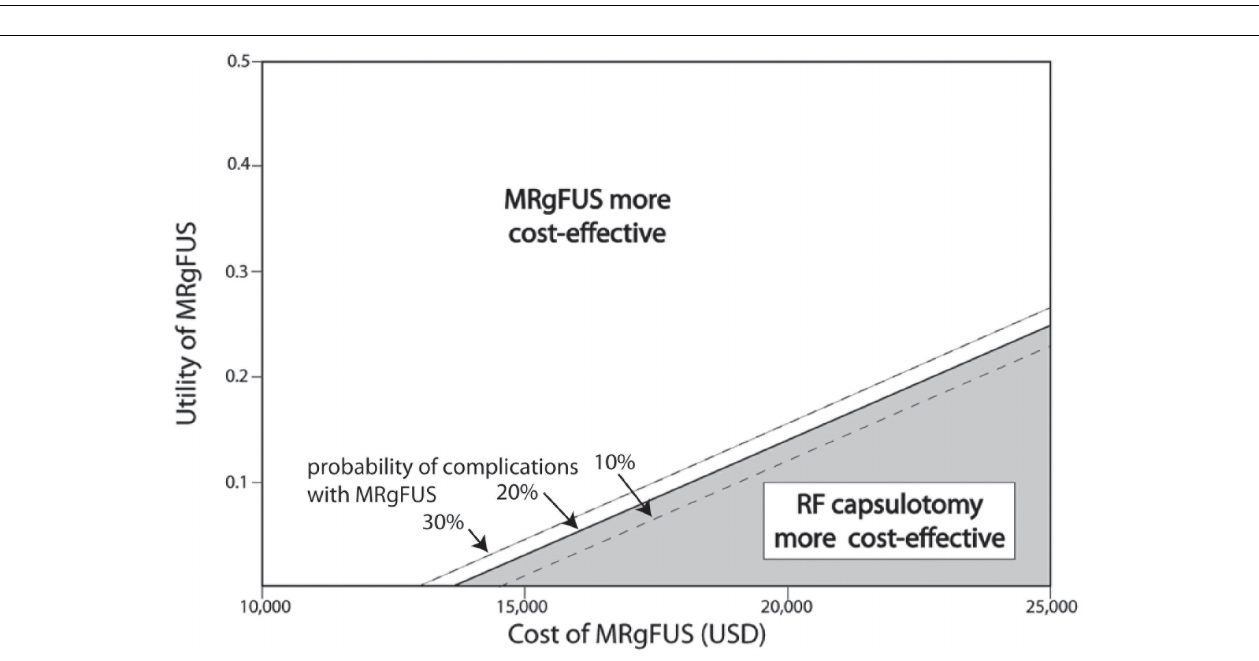
FIGURE 1 | Decision tree comparing MgFUS and RF capsulotomy for treatment-refractory OCD. Possible outcomes of each treatment are listed. Acute complications of RF capsulotomy prolong hospital stays and increase costs. OCD, obsessive compulsive disorder; MRgFUS, magnetic resonance guided focused ultrasound; RF, radiofrequency.